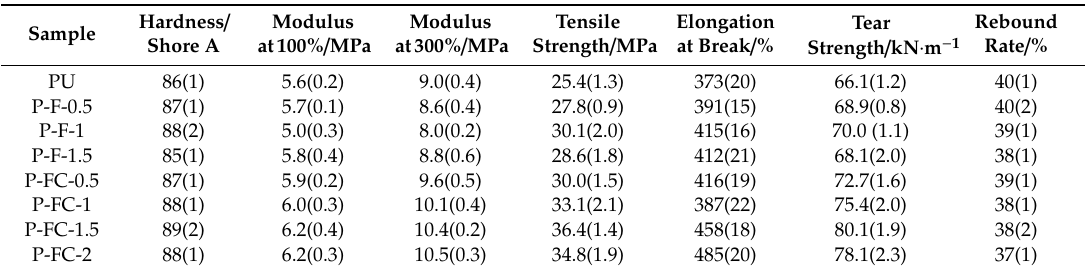
Table 4. Variations in mechanical properties of polyurethane composites with the increasing modified meta-aramid fibrids content.